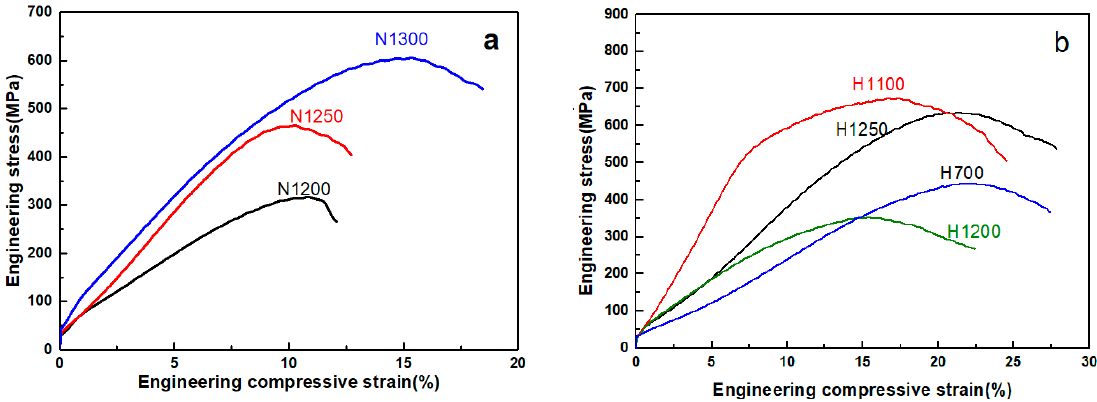
Table 7. Compressive strength and elastic modulus of porous HNASS samples.